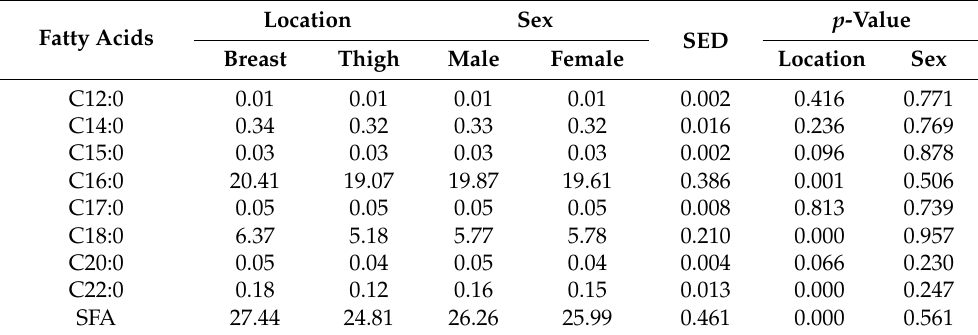
Table 8. Effects of muscle anatomical location and sex on saturated fatty acid (% of total FA) composi- tion of goose meat lipids.